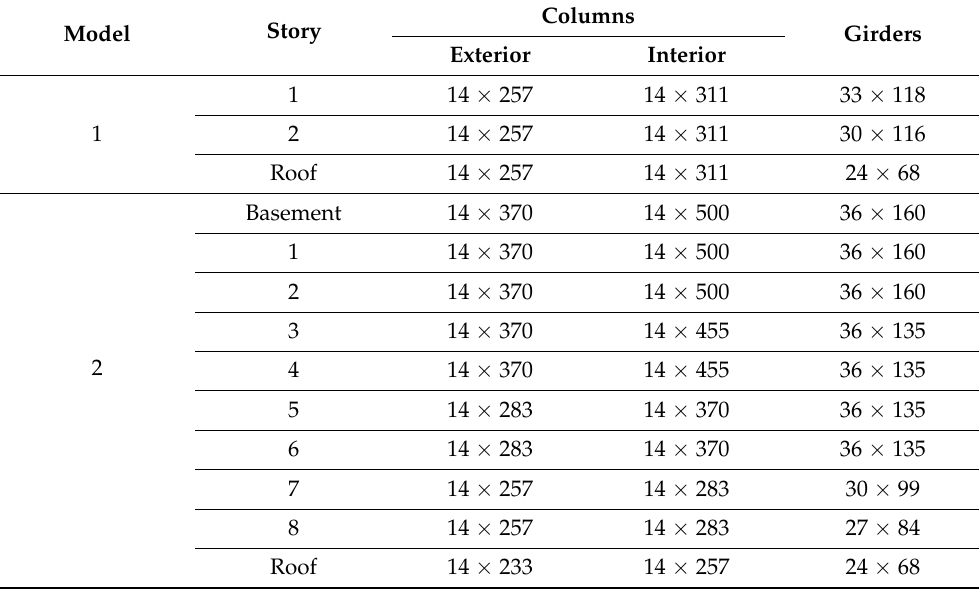
Table 1. Wide-flange sections (W-shapes) used in Models 1 and 2.